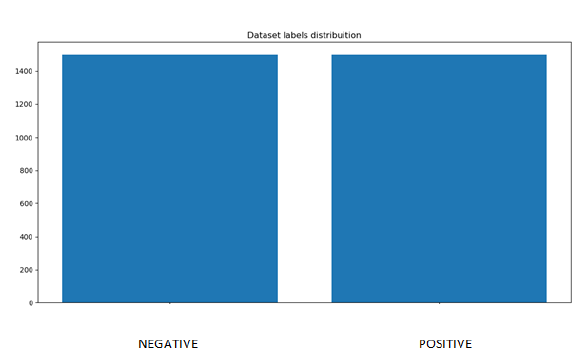
Fig .6.Word Cloud Generation for positive and negative